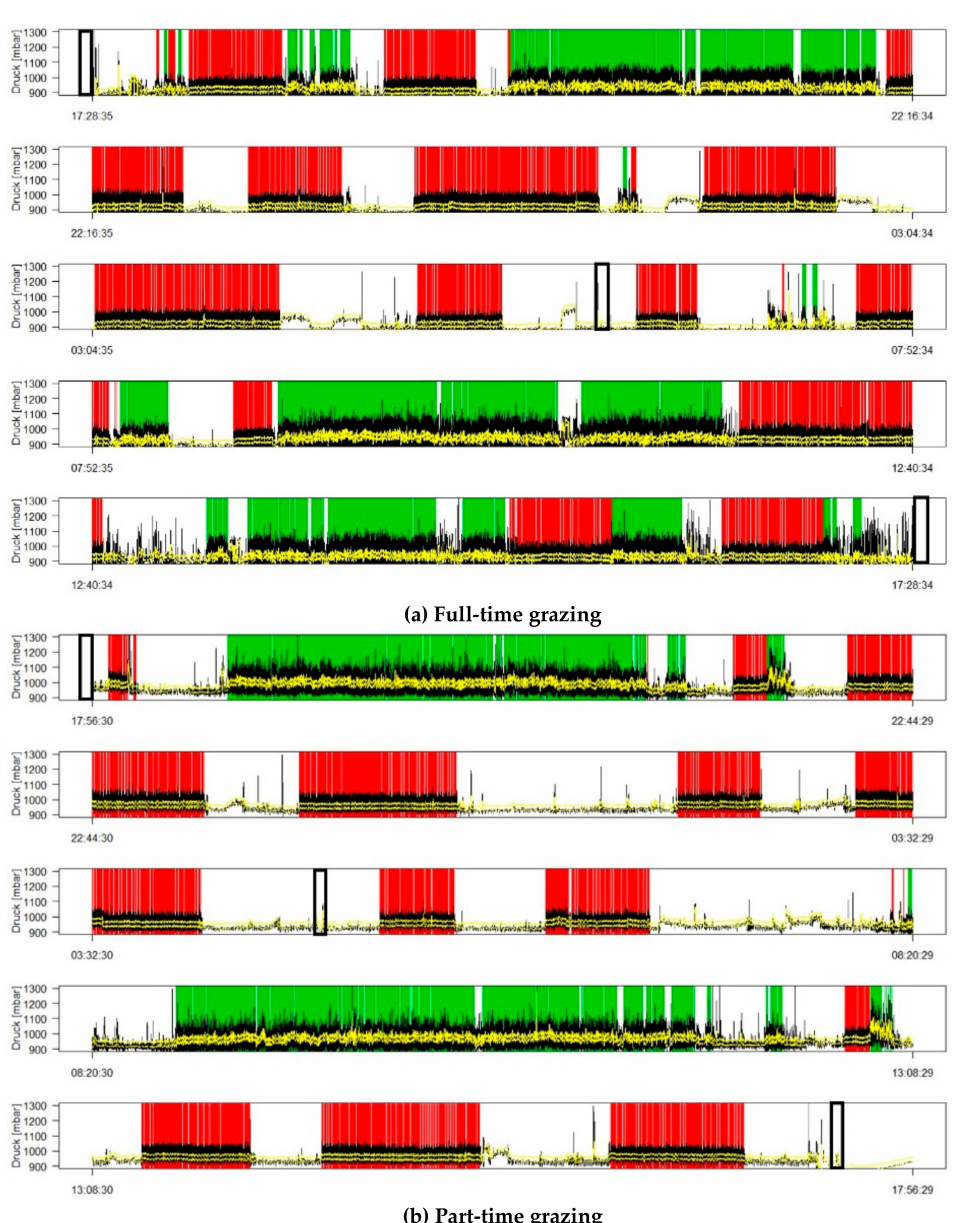
Figure 1. Examples of individual feeding behavior during 24 h for ( a ) full-time grazing and ( b ) part-time grazing with ingestion (green), rumination (red), and idling (white) bouts. Vertical black-lined boxes represent milking